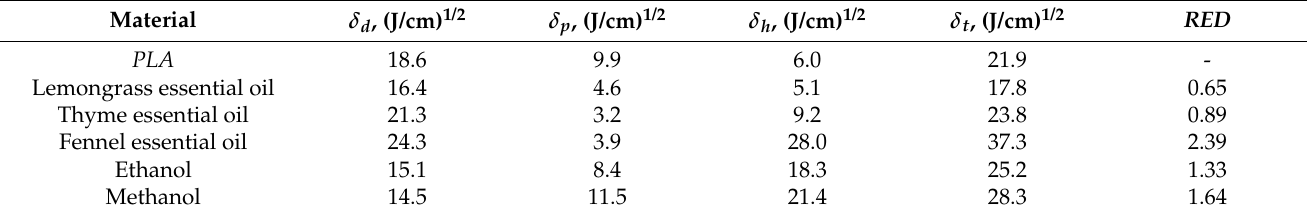
Table 2. Solubility parameters and RED values of essential oils, solvents, and the PLA